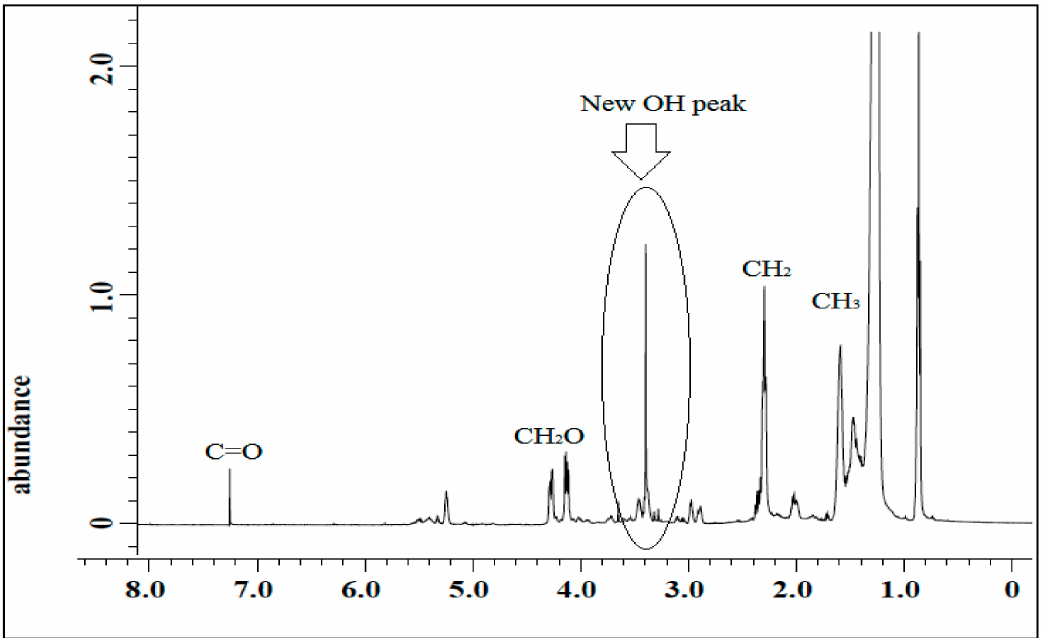
Figure 6. 1 H NMR spectrum of jatropha